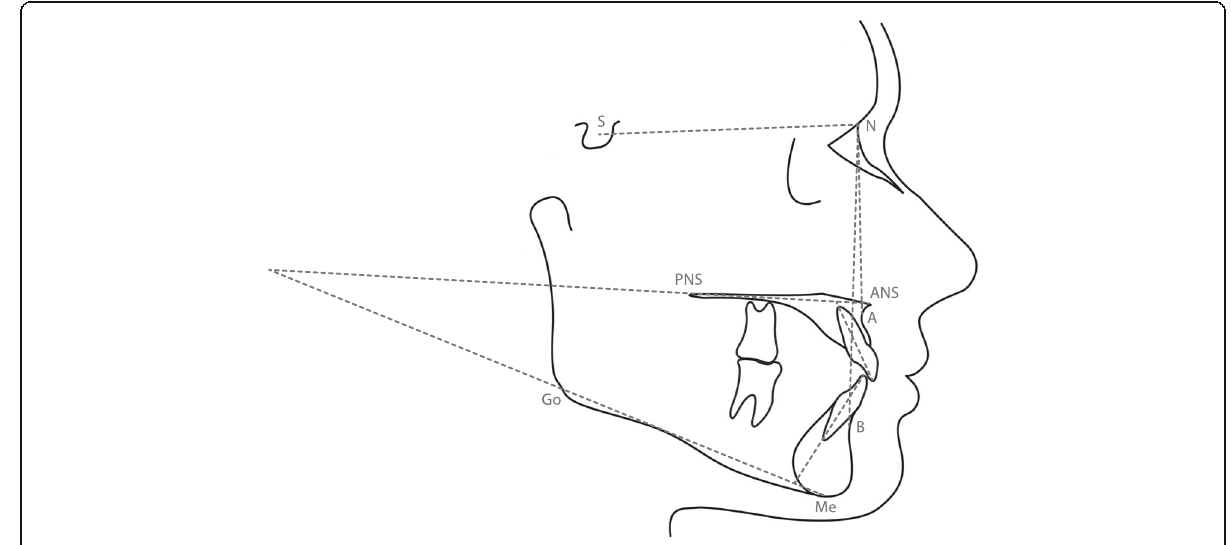
Fig. 1 Cephalometric points, planes, lines and